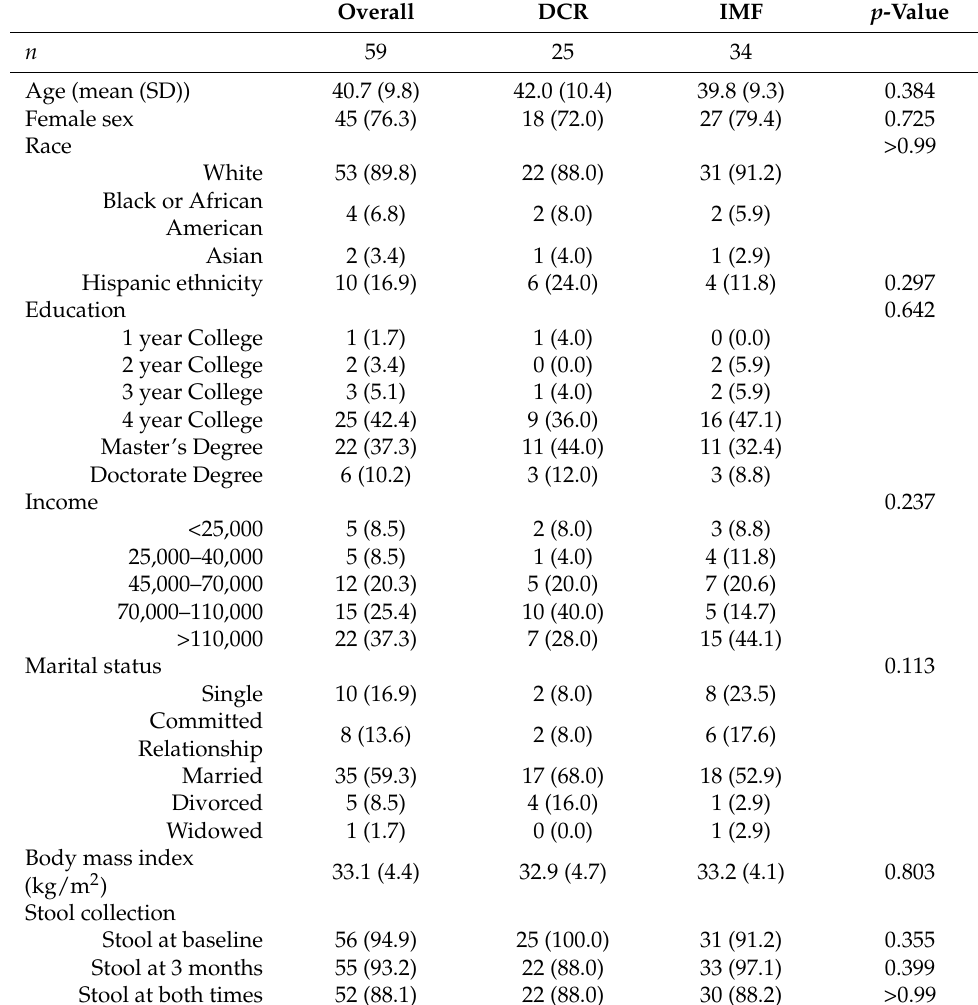
Table 1. Characteristics of study cohort by intervention group. There were no significant differences in characteristics between the intervention groups at